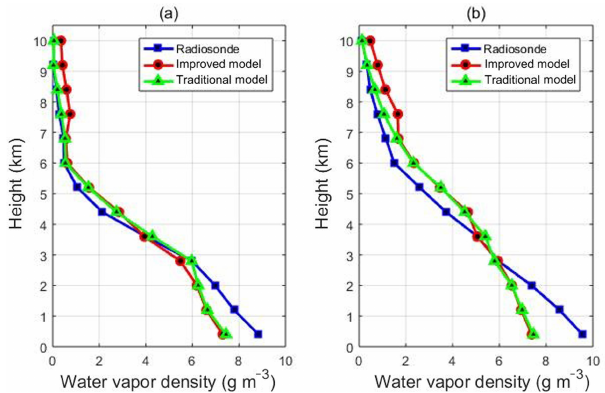
Figure 6. Water vapor profile comparison derived from differ- ent tomographic methods and radiosonde, (a) a non-rainy day at 00:00UTC on 25 March 2014, and (b) a rainy day at 00:00UTC on 7 April